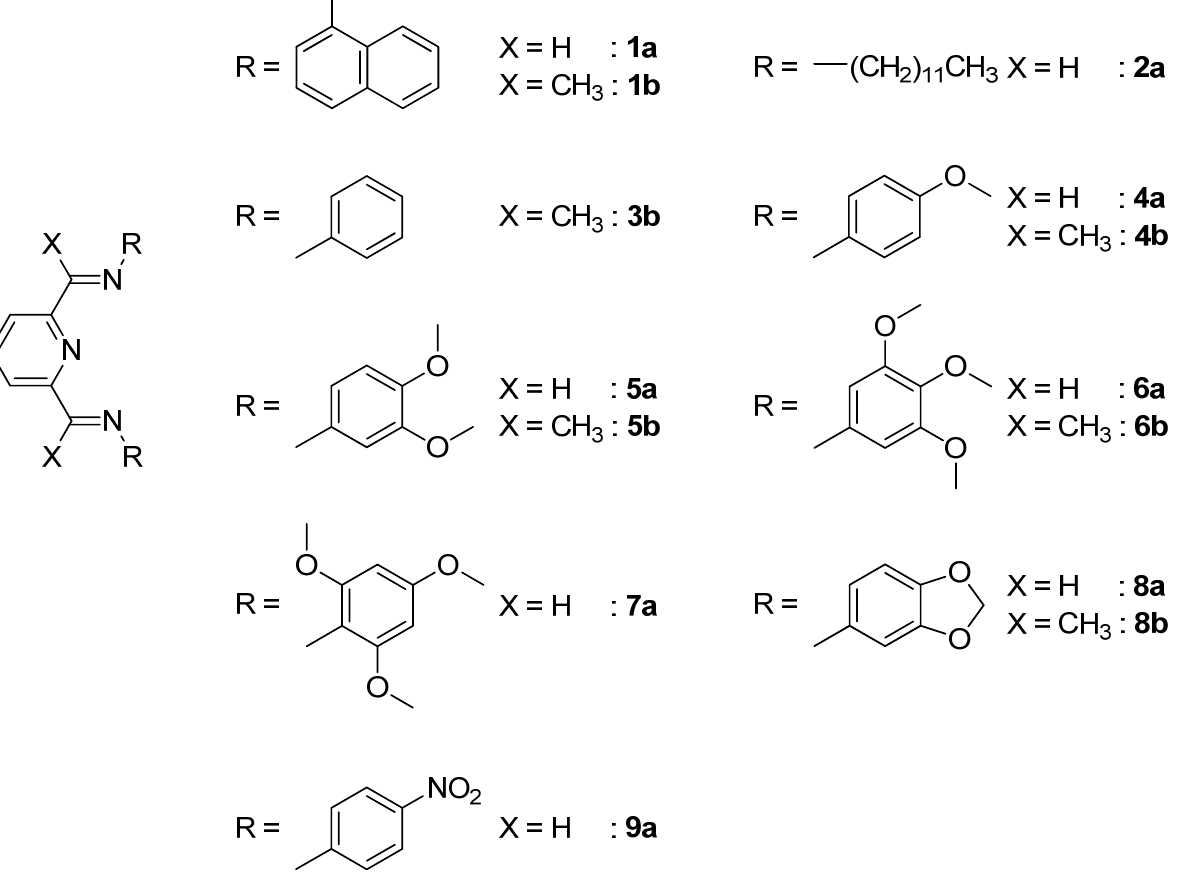
Figure 1. Structures of the di(imino)pyridine derivatives investigated.